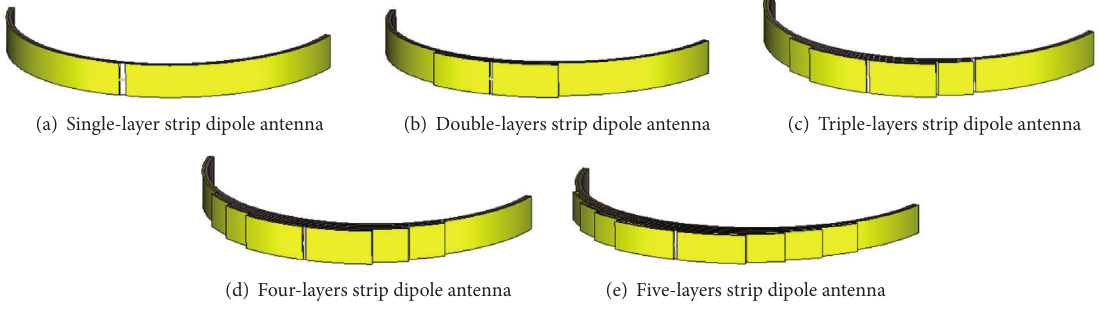
Figure 8: Multilayers strip dipole antenna model (not true